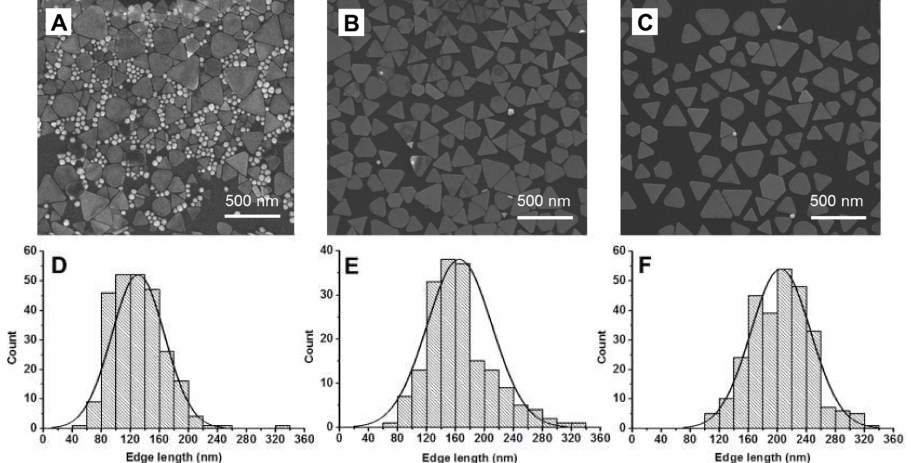
Figure 3. ( A – C ) Scanning electron microscopy (SEM) micrographs corresponding to 1100NPr /